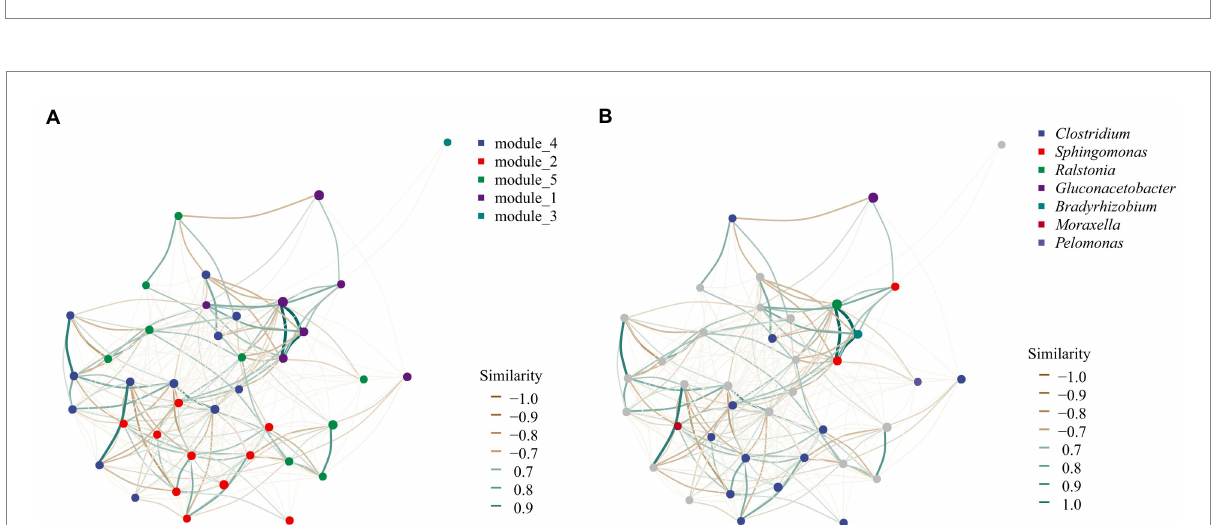
FIGURE 5 Co-occurrence network analysis of bacterial community modules and genera based on SparCC method. (A) The module distribution of network analysis. Five different colors of dots were used to represent the five modules, representing the possible functional groups. (B) Network structure at the genus level. Each point can be called a node, which can represent an ASV or a taxon in the community. The connecting line between two points can be called edge, which represents the distribution trend of positive or negative correlation between the two points connected.